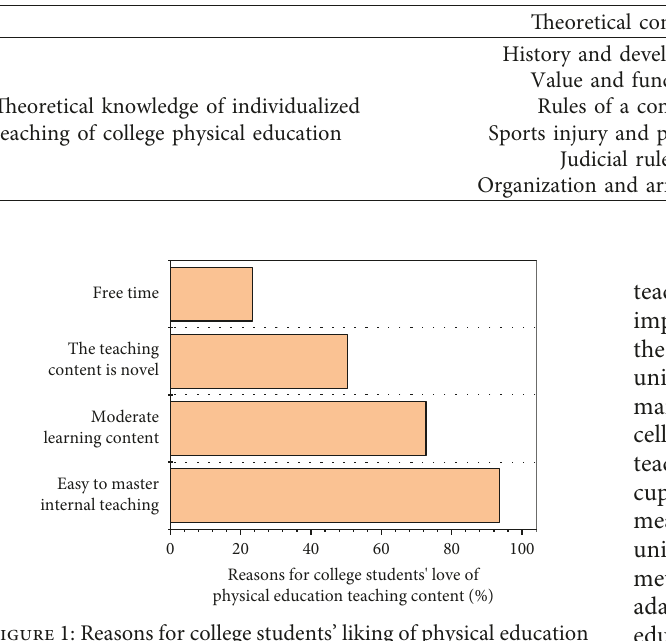
Table 6: Theoretical knowledge of individualized teaching of college physical education ( n � 408).